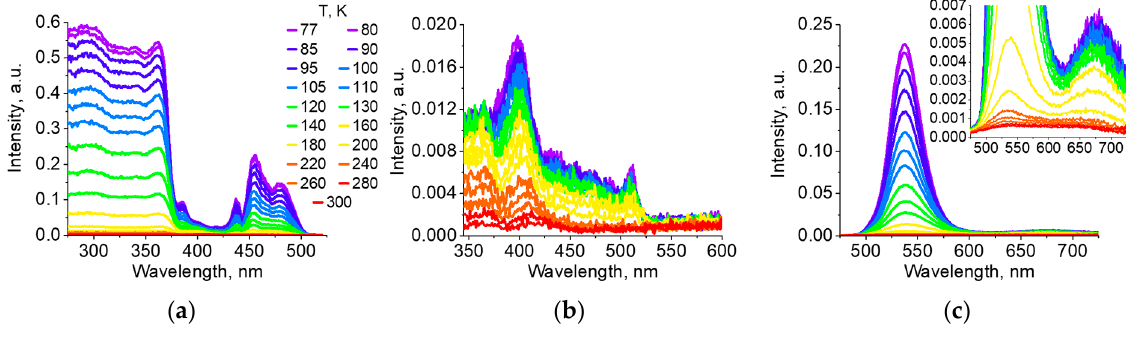
Figure 2. Temperature dependences—of the photoluminescence excitation spectra of ( 1 ) : ( a ) λ Em = 538 nm, ( b ) λ Em = 670 nm ; and of its photoluminescence spectra ( c ) λ Ex = 455 nm. Table 1. Photophysical data for the polycrystalline compound 1 .